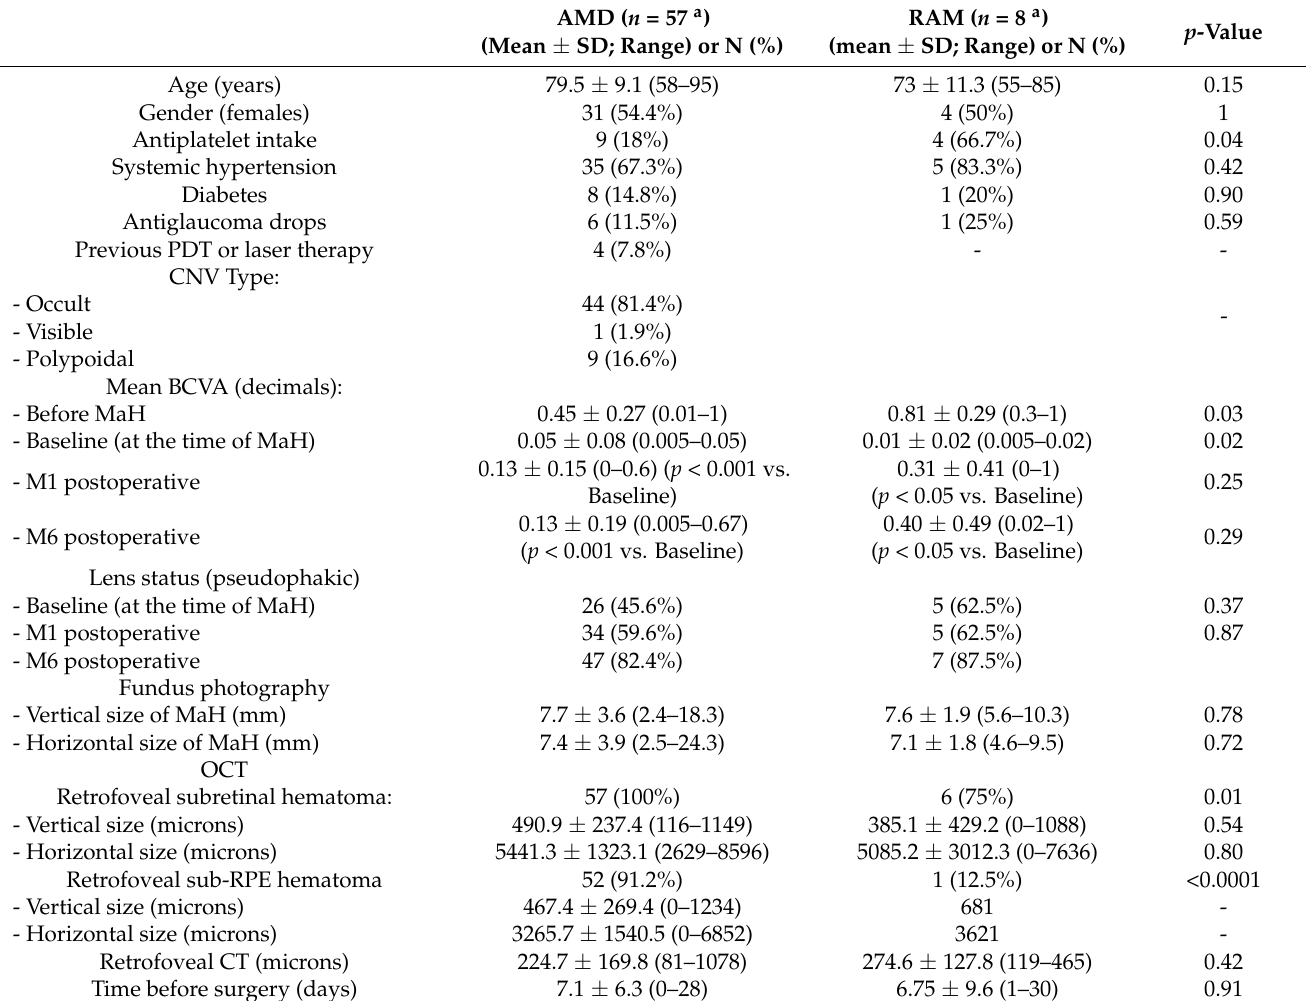
Table 1. Patient demographic and clinical